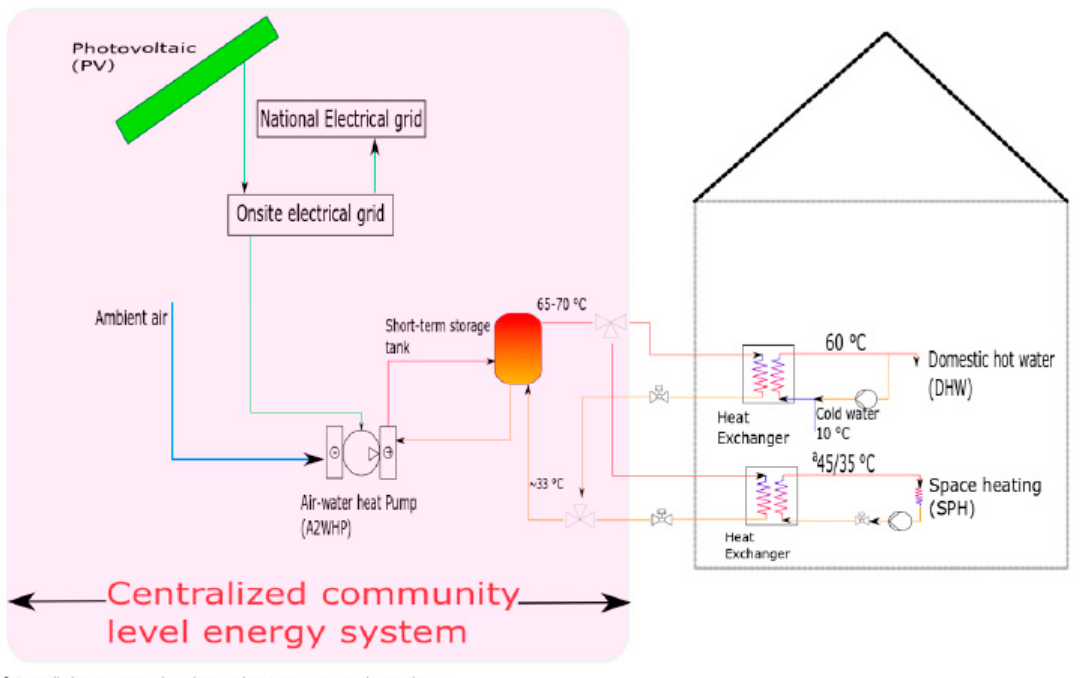
Figure 4. The schematic diagram of the centralized PV and A2WHP-based community-level district heating system integrated with old residential buildings in the district (Case 2, PV + A2WHP).